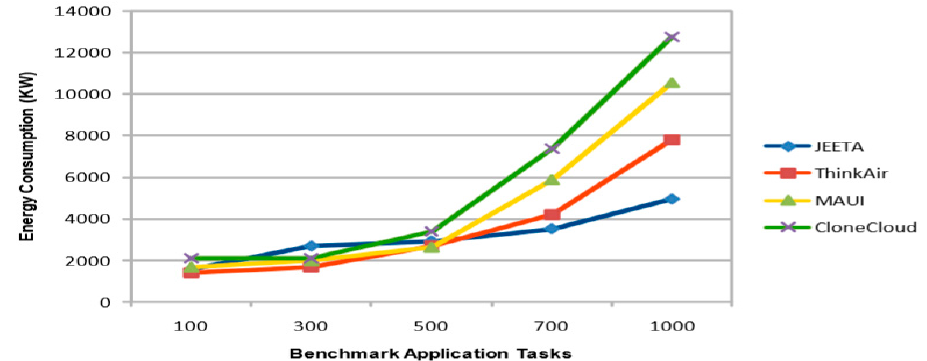
Figure 5. Workflow application: Number of tasks completed within a given deadline.